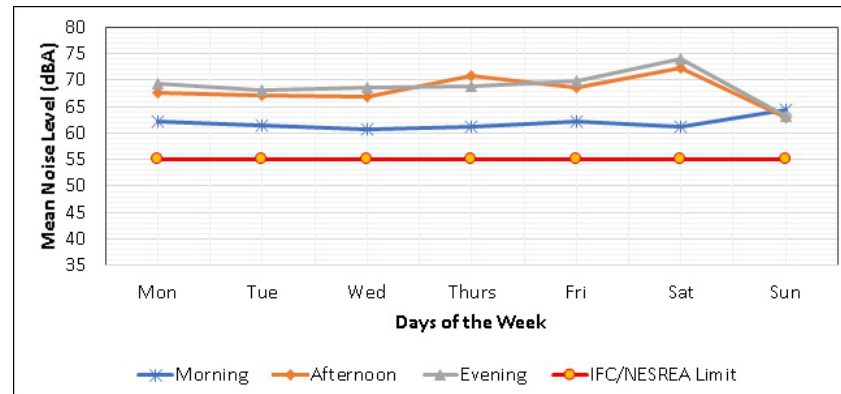
Figure 8: Comparison of the observed mean noise levels against the IFC EHS and NESREA limit